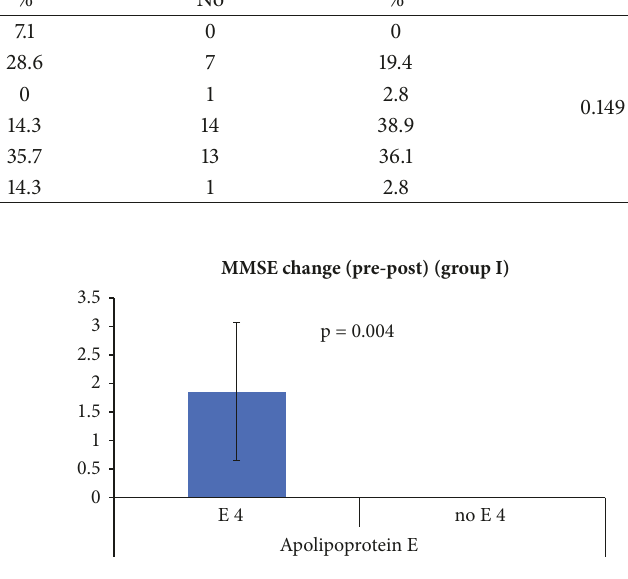
Table 2: Number and percentage of different ApoE genotypes in Group I and Group II patients. Genotypes